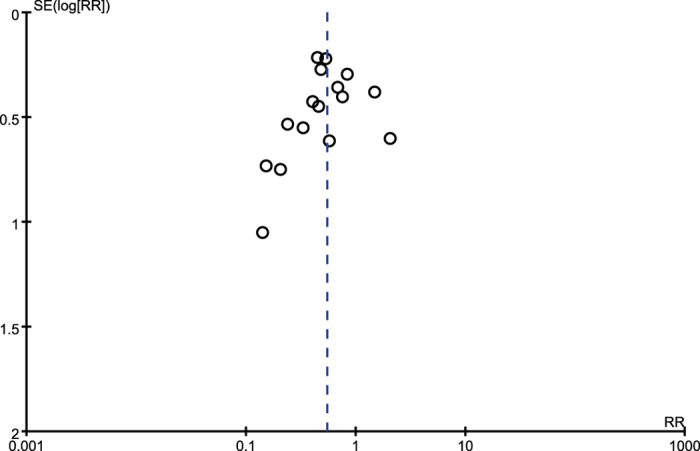
Funnel plot of all included studies did not show asymmetry.Statistical analysis suggested no evidence of publication bias with Begg test and Egger text (P = 0.198 and P = 0.431, respectively). RR, risk ratio; SE, standard error.